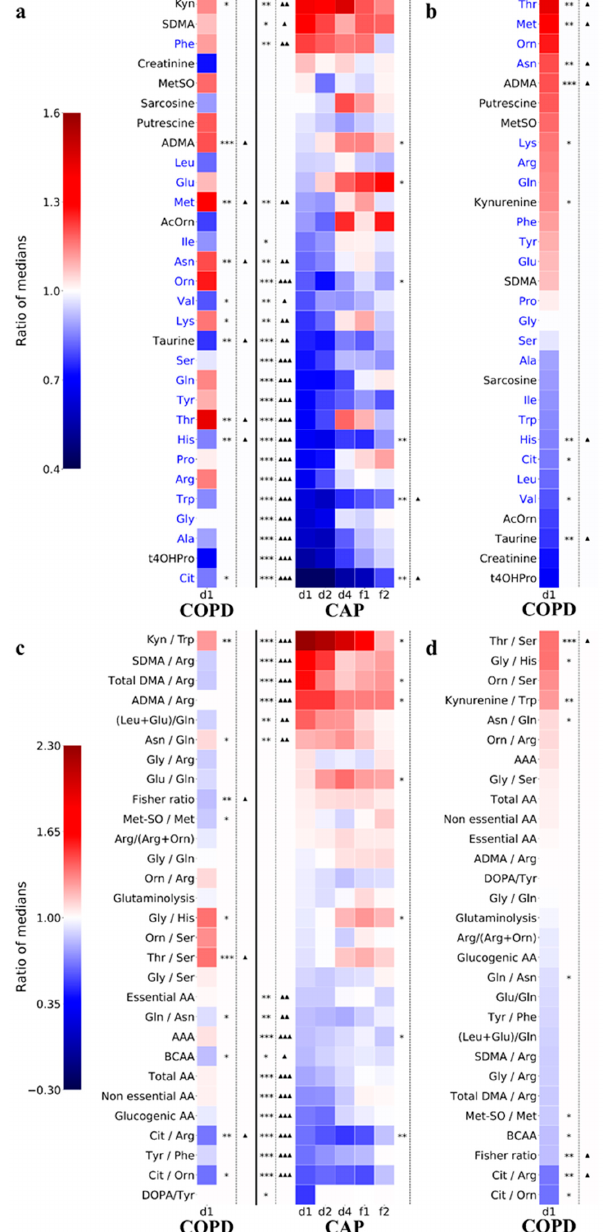
Figure 2. Marked decrease in plasma amino acid concentrations in CAP. Analysis based on the same 20 amino acids and 10 amino acid metabolites, and 29 metabolism indicators as in Figure 1.